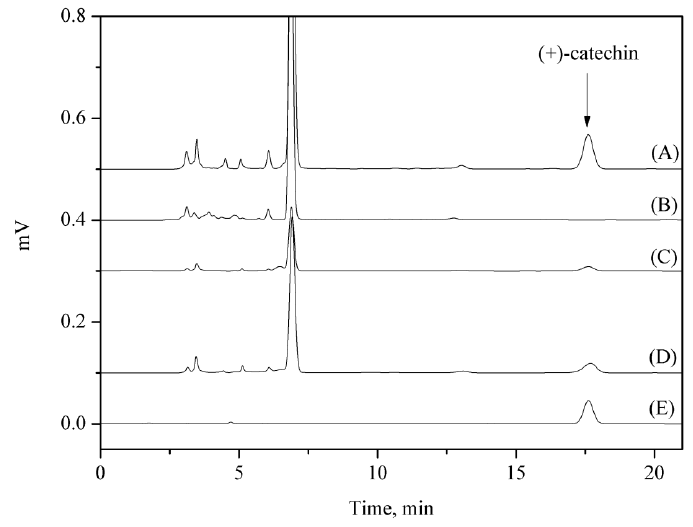
Figure 8. Chromatograms of SPE with different steps. (A) extracted solution, (B) washing by water, (C) washing by acetonitrile, (D) washing by methanol, and (E) elution by methanol/water (containing 1% vol. of acetic acid).